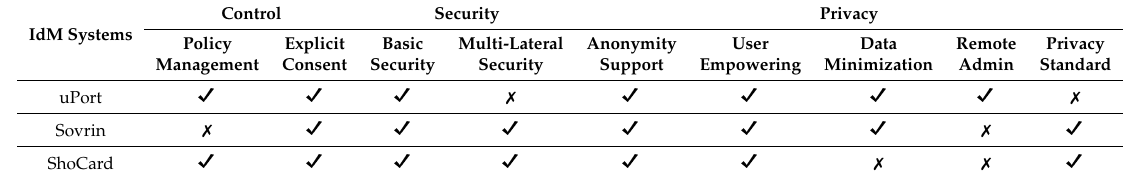
Table 1. Identity management system’s comparison table. IdM, identity